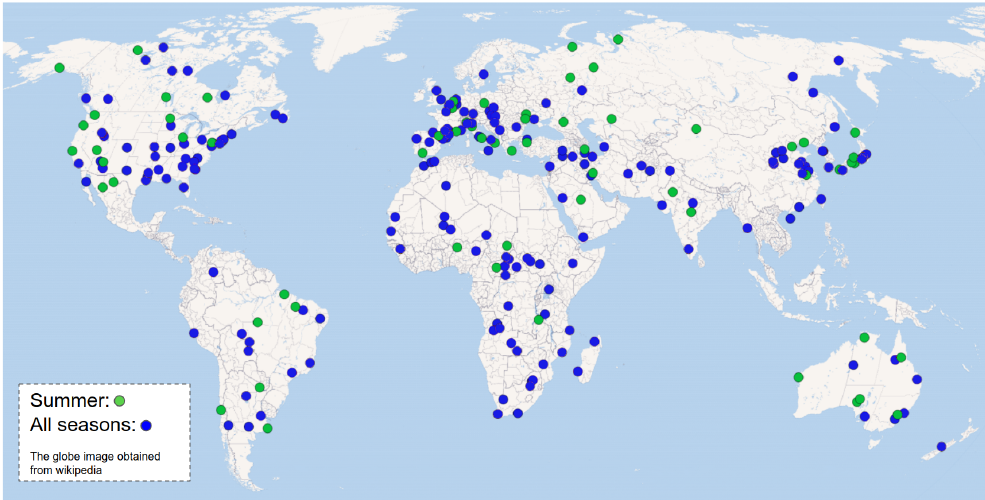
Figure 5. Green indicates 65 sampled locations from the SEN12MS Summer dataset and blue covers All seasons and 256 globally distributed locations in